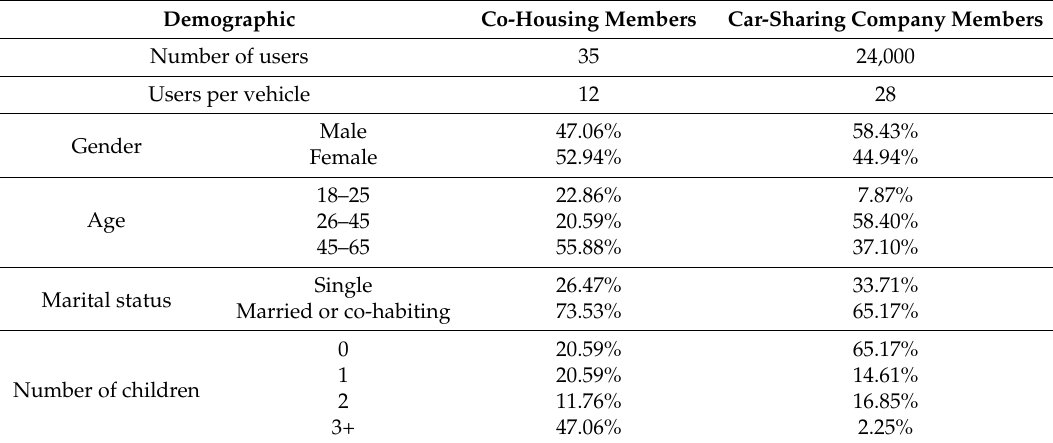
Table 1. Demographic characteristics of the user groups.